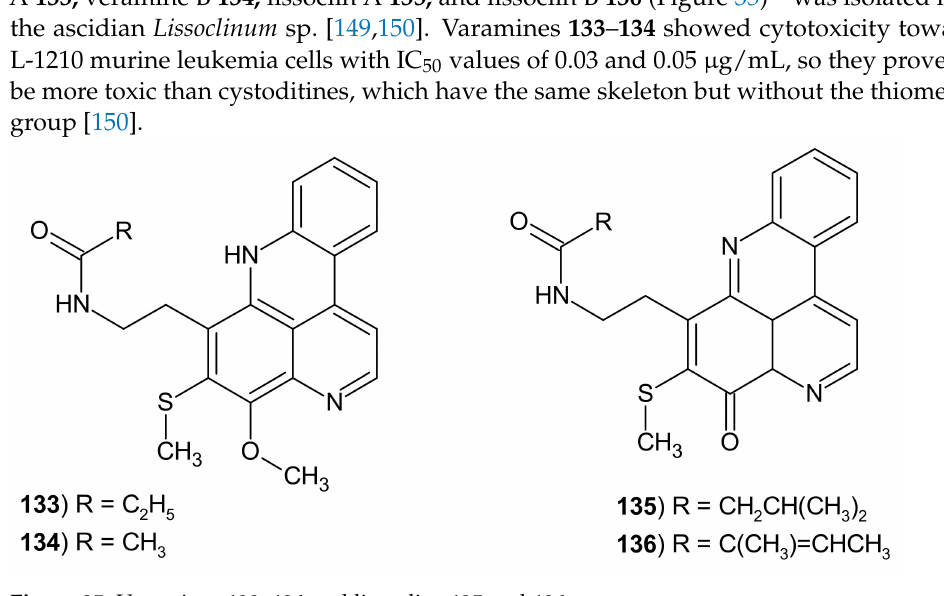
Figure 35. Veramines 133 , 134 and lissoclins 135 and 136